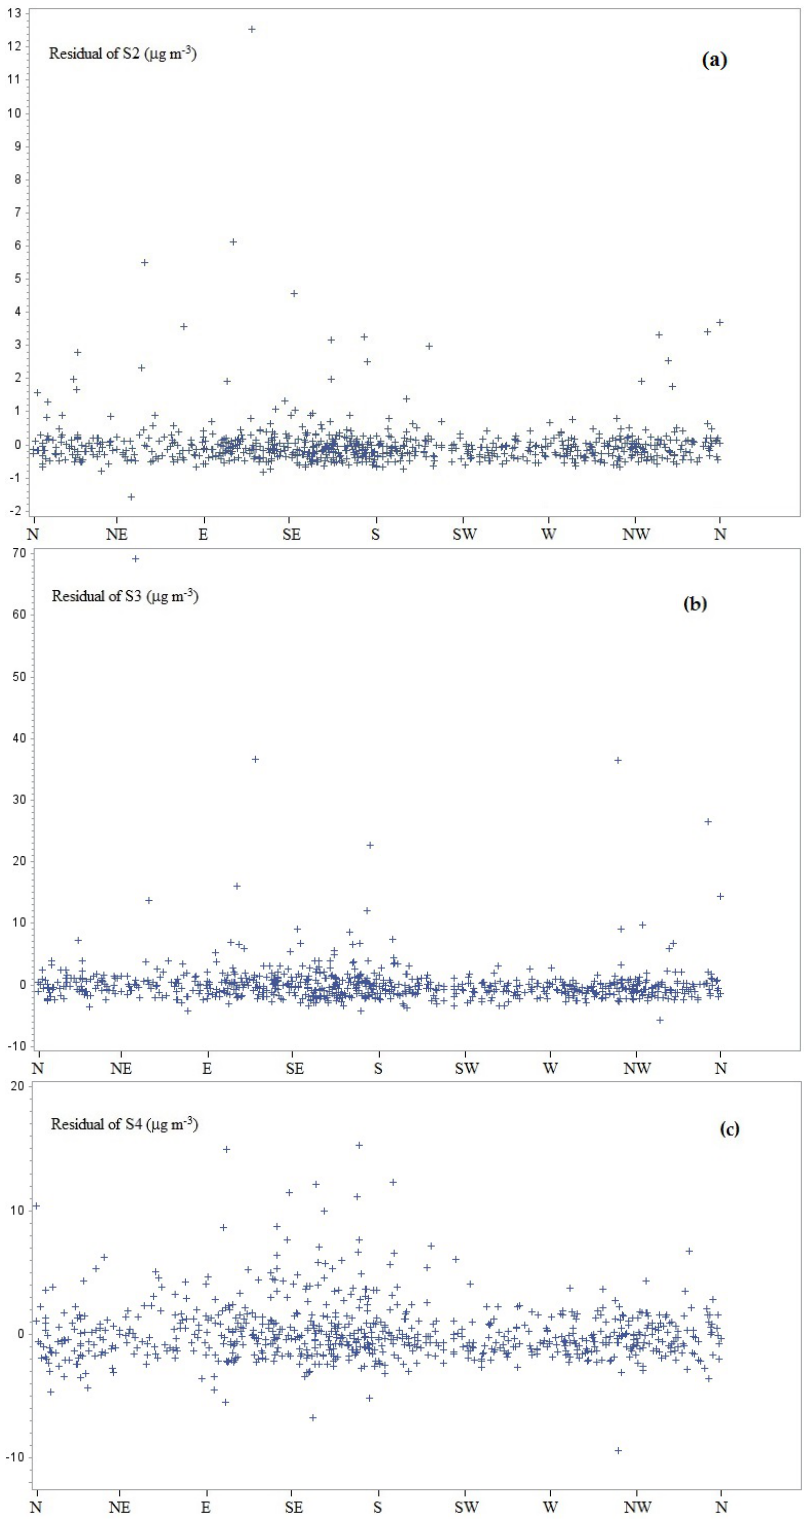
Figure 3. Effect of wind direction on model residual of ( a ) S2—primary smoke particles; ( b ) S3—secondary organic aerosol; and ( c ) S4—sulfate/industrial.